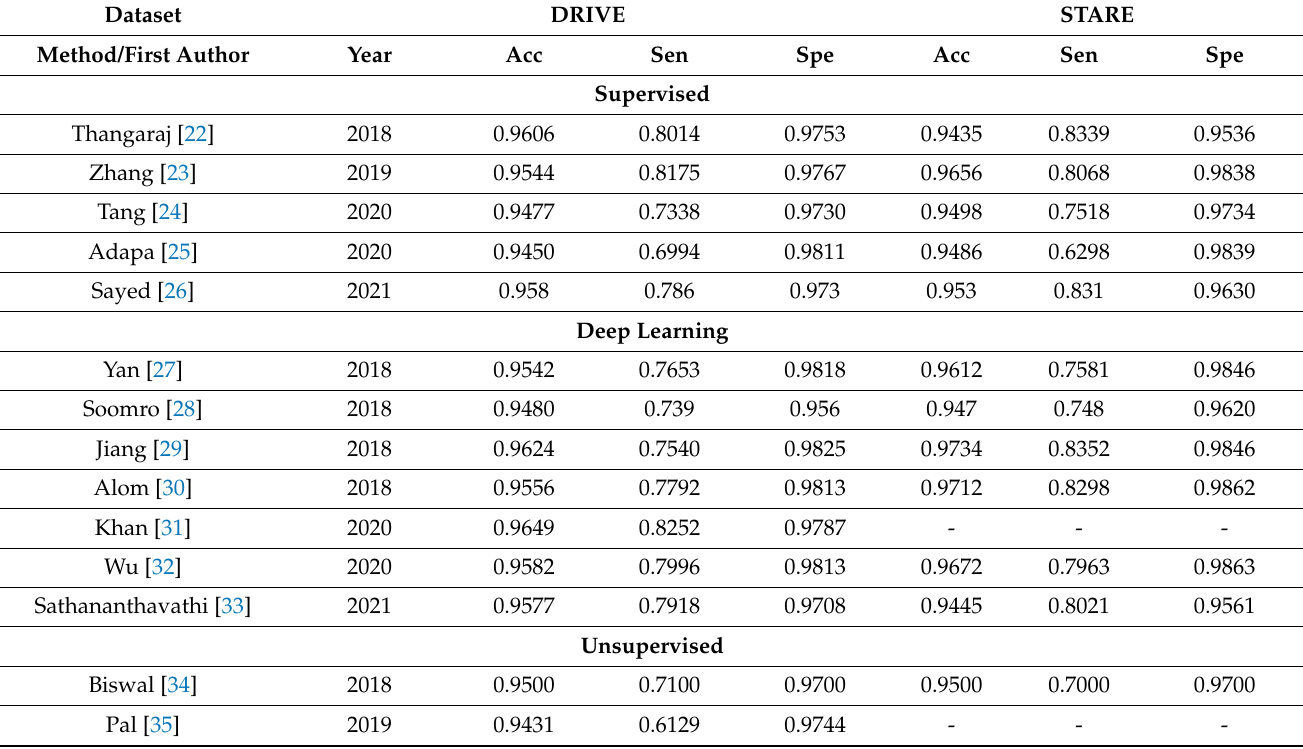
Figure 3. Worst case accuracy: First column indicate color images, second ground truth and third segmented images. First row contains DRIVE images and STARE images are there in the second row. Last column, white indicate the pixels of true positives; while green pixels denote the missed vessel pixels, whereas red refer false positives. Table 4. Performance comparison of proposed method with other state-of-the-art methods.